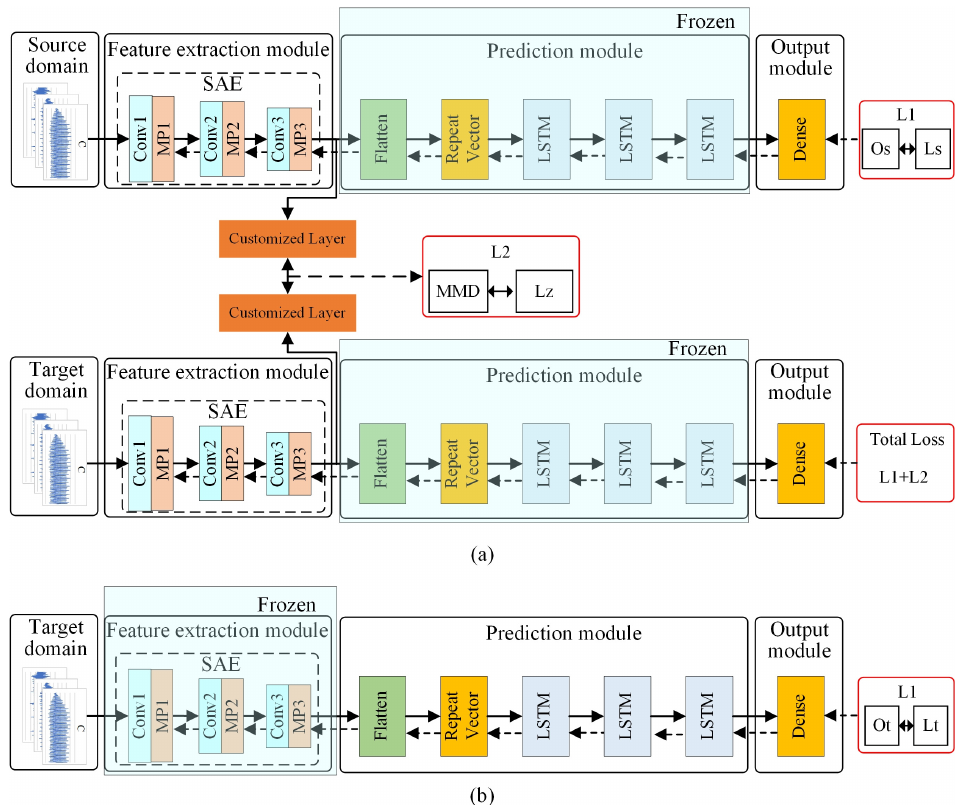
Figure 6. Schematic of fine-tuning: ( a ) Fine-tuning of the feature extraction module; ( b ) fine-tuning of the prediction module.